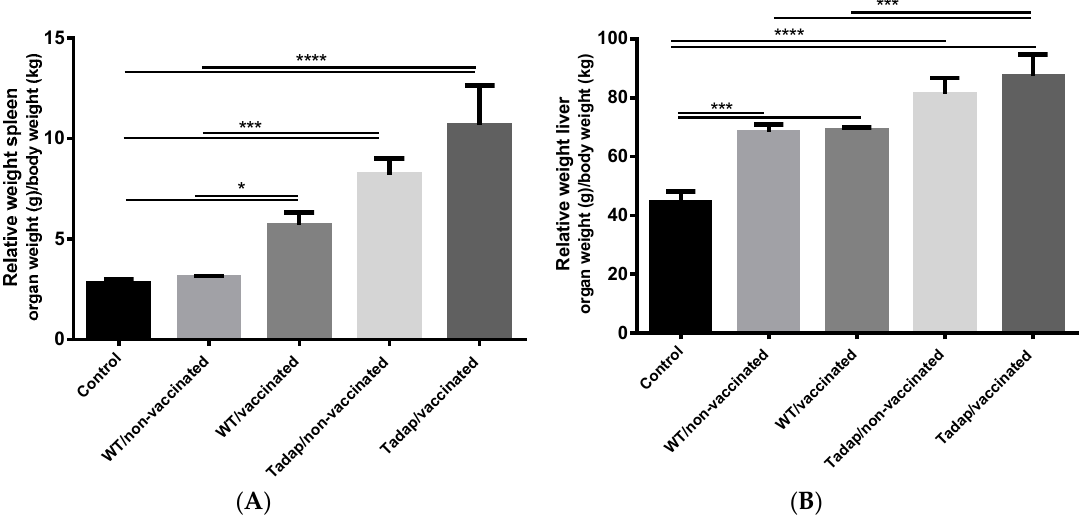
Figure 5. Relative ( A ) spleen and ( B ) liver weight. Balb/c mice were injected (s.c.) twice with PGA+rSsEno (vaccinated) or PBS (non-vaccinated). Seven days after the second dose of administration of PGA+rSsEno or PBS, mice were infected intraperitoneally with 1 × 10 6 conidia of either wild type (WT) or toluene adapted S. schenckii (Tadap). The spleen and the liver of each animal were collected seven days after the second immunization and the relative weight (organ weight/animal weight) was measured. *( p < 0.05); ***( p < 0.001); ****( p < 0.0001).